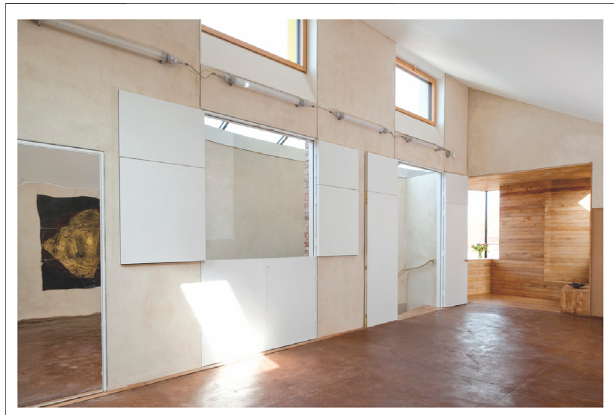
FIGURE 5 | Zero carbon house top fl oor with rammed earth fl ooring (photo with permission from Martine Hamilton Knight/Builtvision).